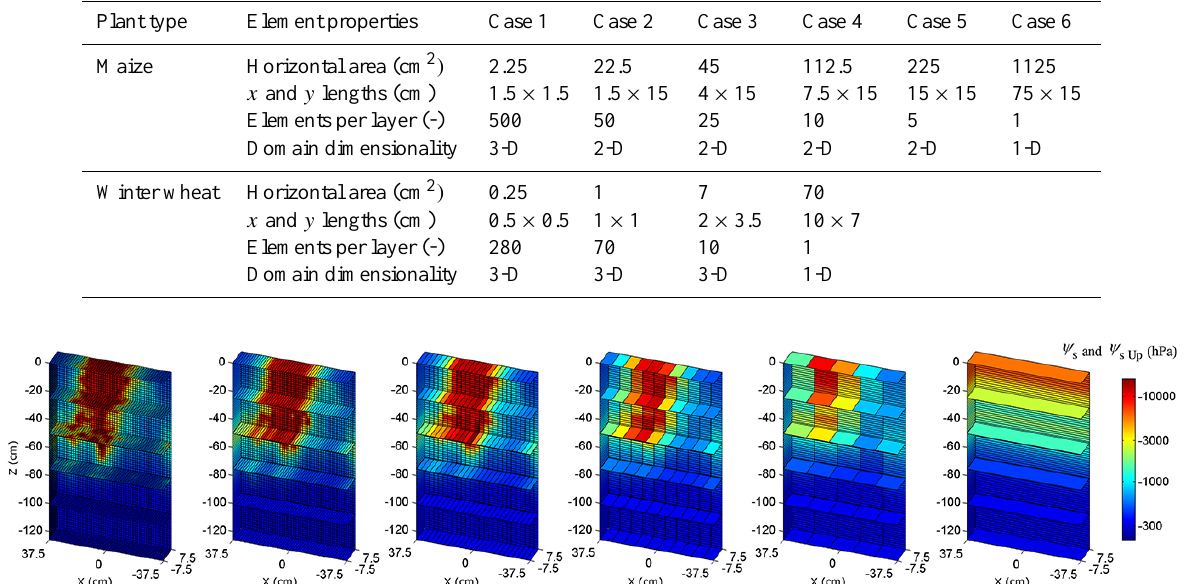
Table 1. Sizes of upscaled soil elements and domain properties for both maize and winter wheat crops in the runs testing the first conjecture.